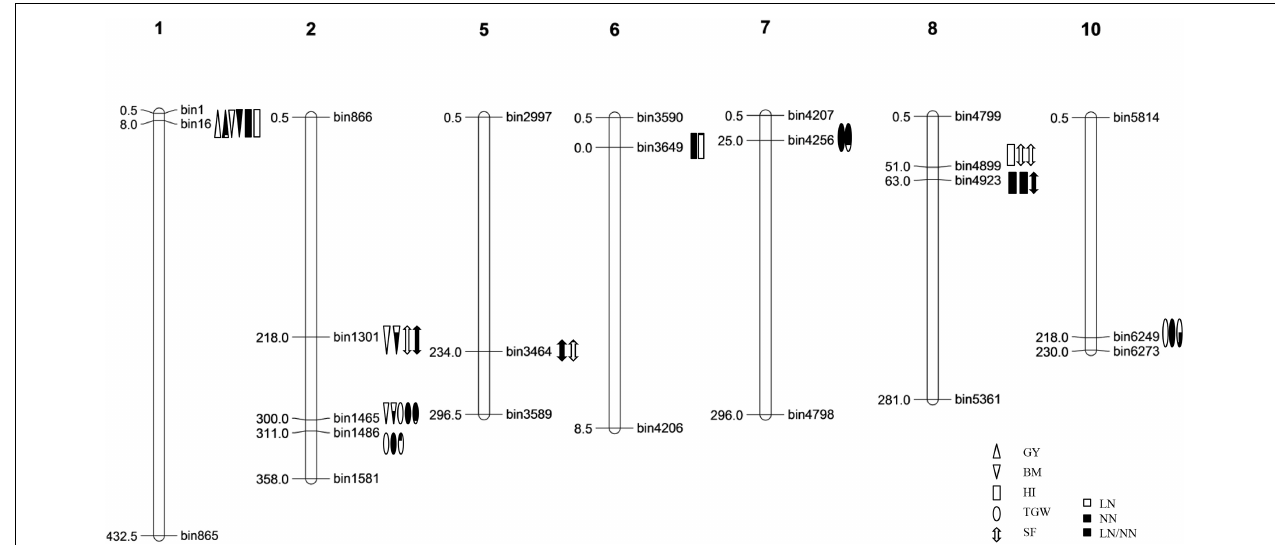
FIGURE 1 | The genetic linkage map and the locations of QTLs for nitrogen deficiency tolerance (NDT)-related traits identified in the IB